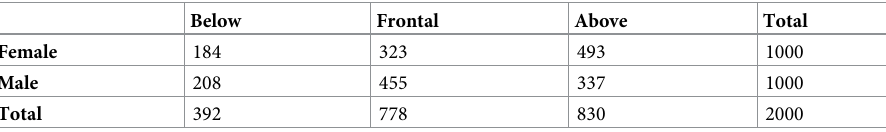
Table 1. Frequencies of rated camera height in female and male